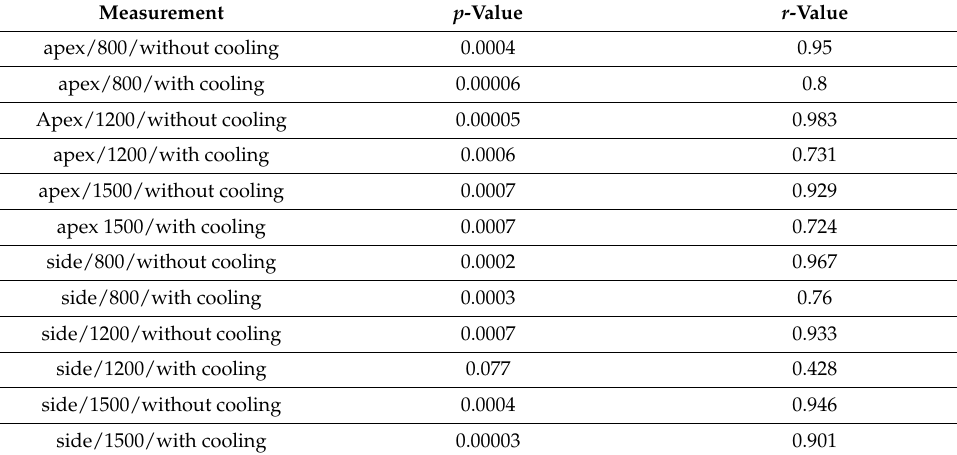
Table 2. Spearman correlation coefficients between the actual temperature and tissue destruction. Apex—at apical part of drill; Side—at lateral part of drill.